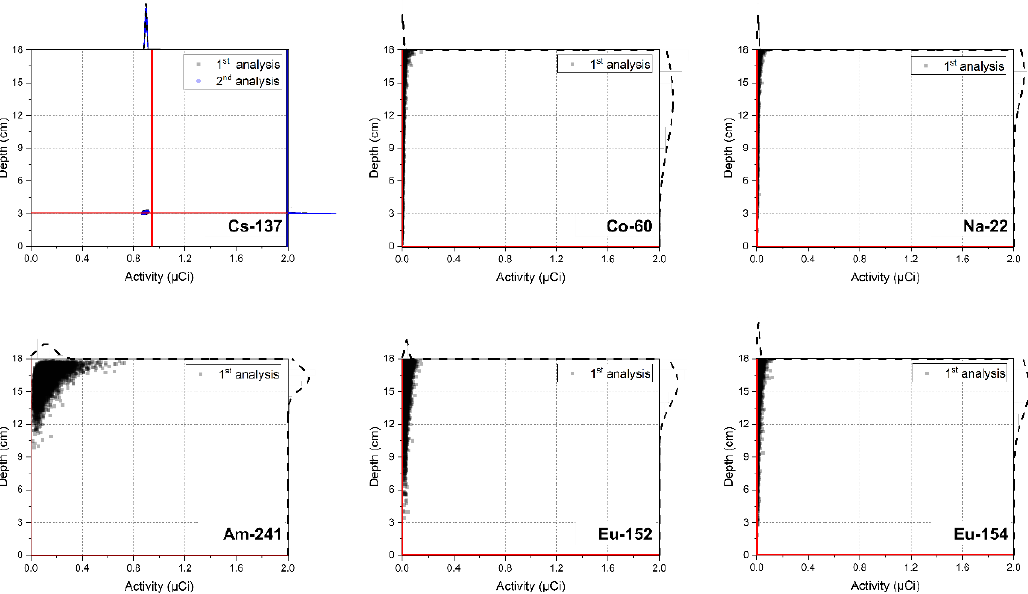
Figure 2. Joint distributions between the depth and activity of the radioisotopes in the radioisotope library for a spectrum acquired for 300 s with a Cs-137 source buried in sand at the depth of 3 cm. The scatter dots represent the correlations between the depth and activity, while red lines and the curves outside the plot area represent their true values and corresponding densities, respectively. The distribution from the first analysis is obscured by that of the second analysis and is hardly visible in the plot for Cs-137.